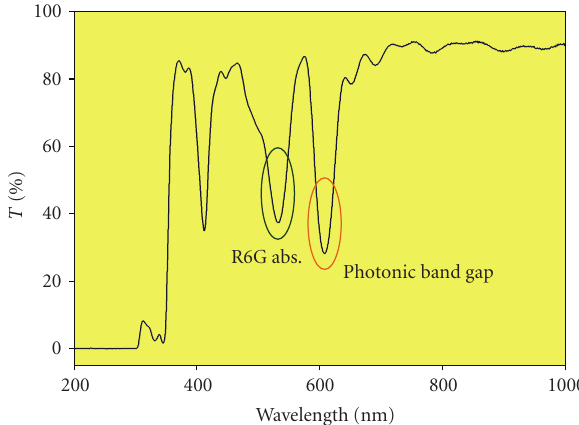
Figure 2: Transmission spectrum of the (PVK/CA) 9 PVK multi- layer. The green oval indicates the Rhodamine 6G absorption, while the orange oval indicates photonic band gap. At about 400 nm, the higher order photonic band gap is present